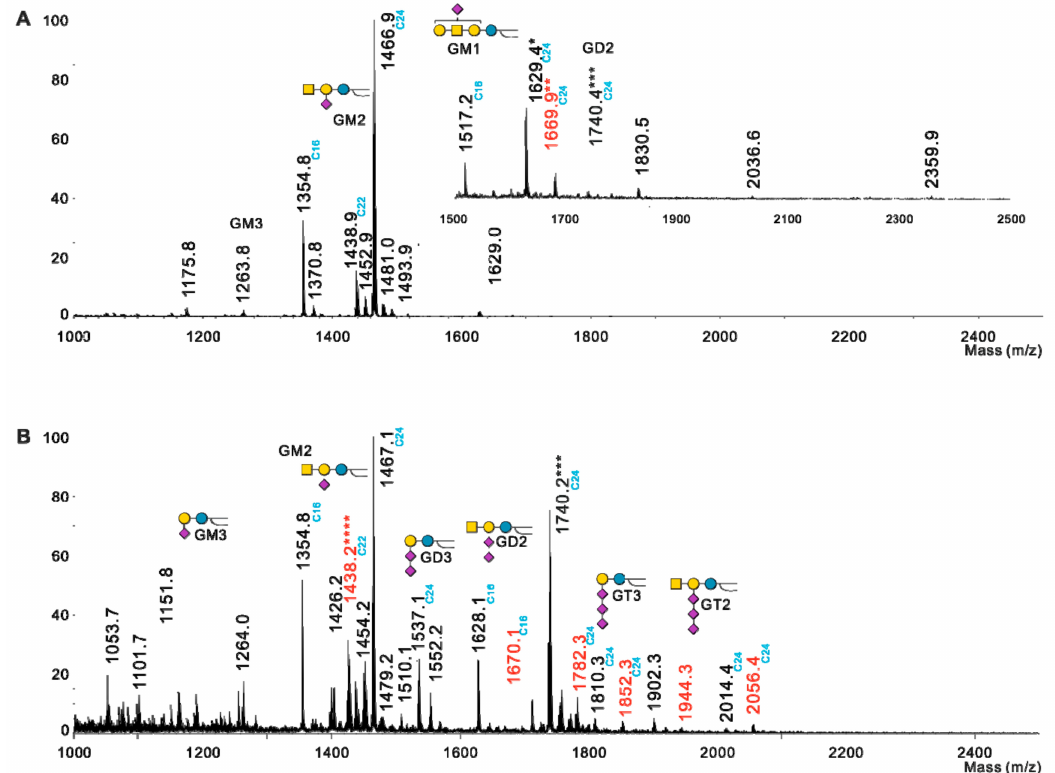
Figure 3. Gangliosides profiling by representative MS spectra in Hs 578T ( A ) and MDA-MB-231 GD3S + #4 ( B ). Ceramide consists mainly of d18:1 long chain base and C16, C18, C24 either / both saturated or / and saturated fatty acids. Red signals identify acetylated gangliosides species and black signals non-acetylated forms of gangliosides species. The nature of long fatty acid chain is indicated in blue on the spectra. * and *** indicates that GD2 Cer 16 and O AcGT3Cer 16 are respectively present in traces amount; ** indicates that signal corresponds to a mixture of O AcGM1Cer 24 with O AcGD2Cer 18 ; **** indicates that signal corresponds to a mixture of GM2 with O AcGD3. Gangliosides are depicted according to the following Ceramide; Galactose; Glucose; N -acetyl-galactosamine; N -acetyl-neuraminic